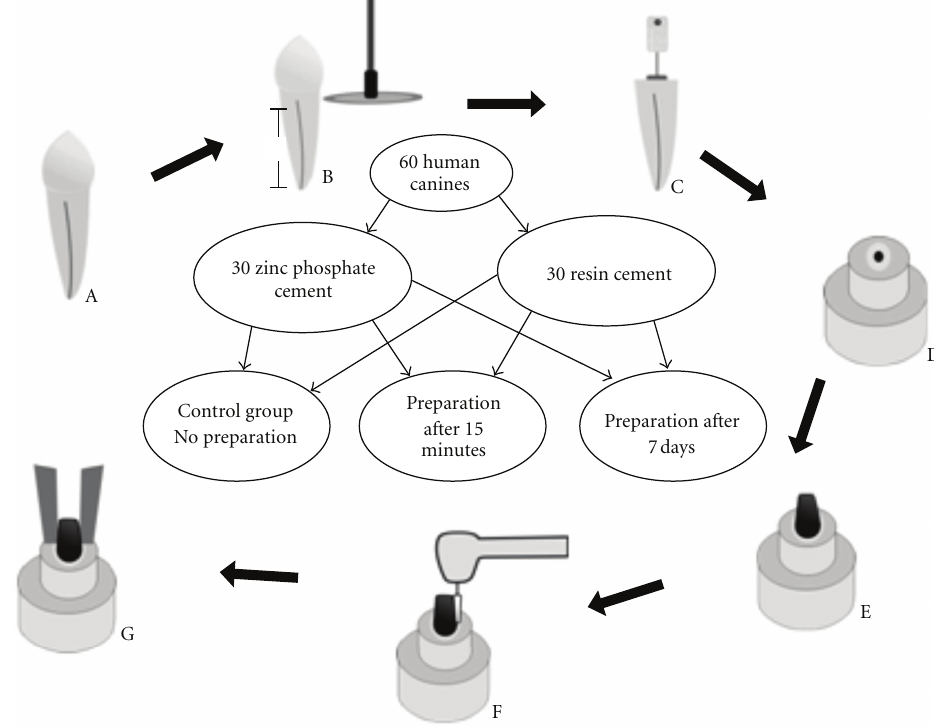
Figure 1: (A) Recently extracted canine. (B) Section of tooth. (C) Endodontic treatment. (D) Embedded sample. (E) Cemented cast metal core. (F) Coronal preparation of core. (G) Tensile